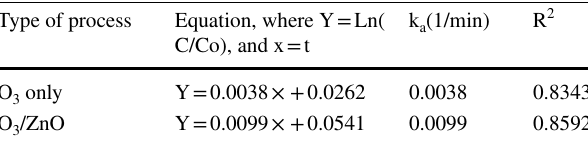
Table 2 The results of experimental kinetic data of degradation in SOP and COP reaction with the second-order equation Type of